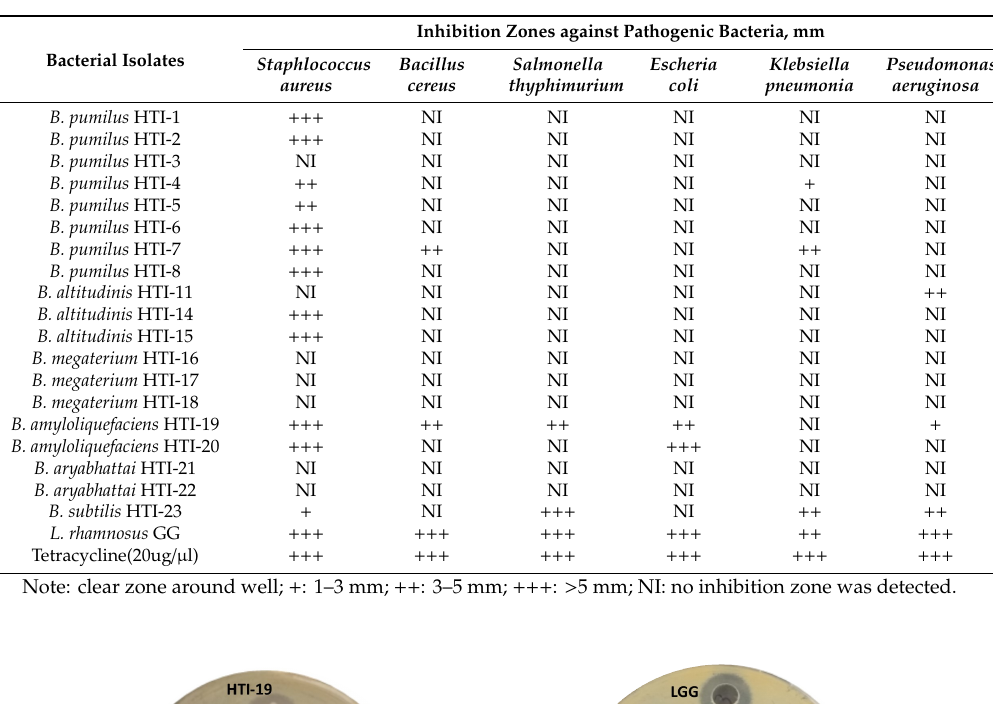
Table 2. Antagonistic activities of Bacillus species against six di ff erent pathogenic bacteria.